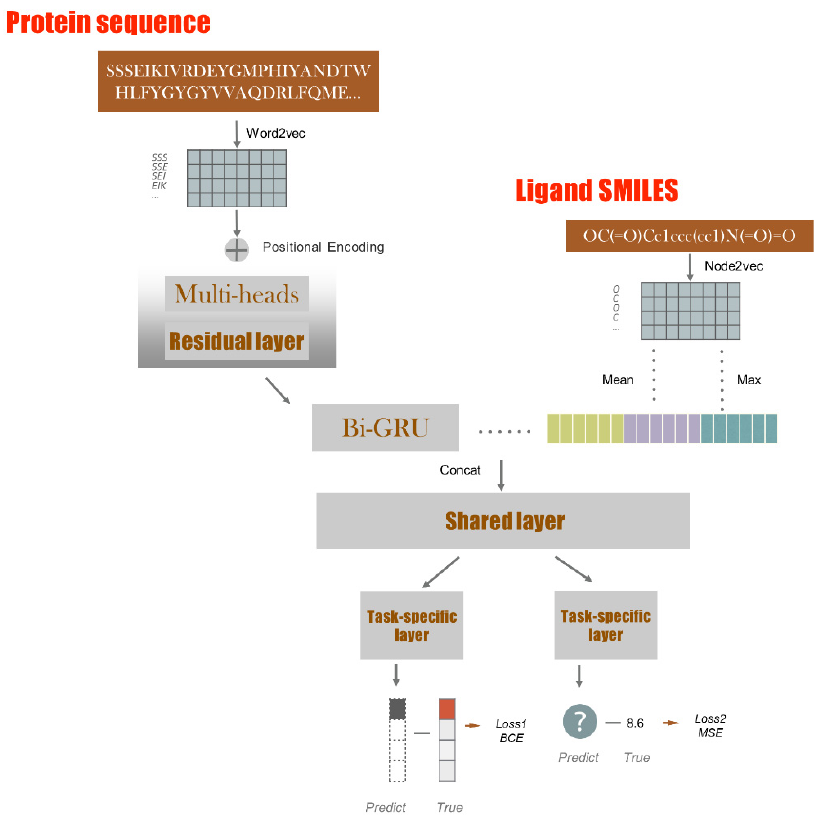
Figure 1. Schematic of the proposed model. The model involves two parts: protein/ligand feature extraction and their interaction prediction. First, the protein sequence is processed in turn by word2vec [13], multi-heads residual layer and Bi-GRU (bidirectional gated recurrent unit) modules. Ligand smiles is processed by node2vec [14]. Then, their representations are fed into a shared layer and task-specific layer and connected to the labels.